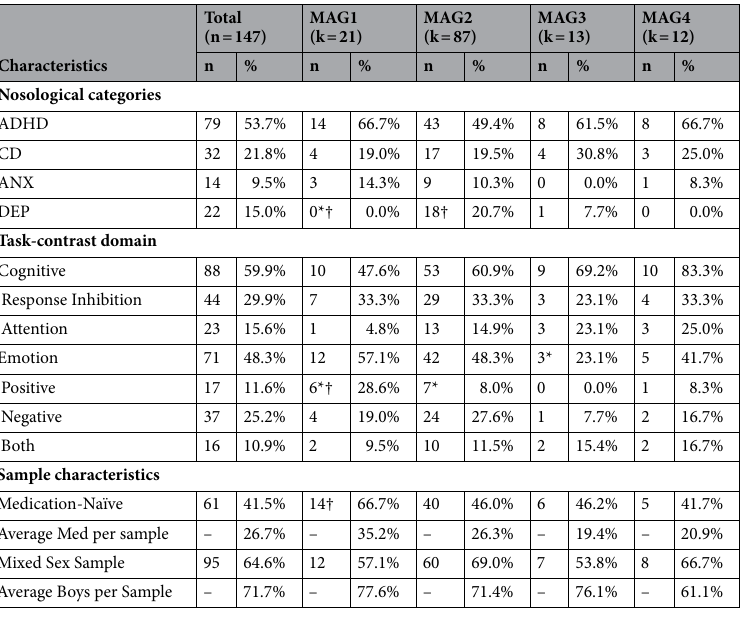
Table 2. Characteristics of Experiments across meta-analytical groupings. *Represents significant difference compared to its base rate (one-tailed p < 0.05). † Represents significant differences between MAGs (p <